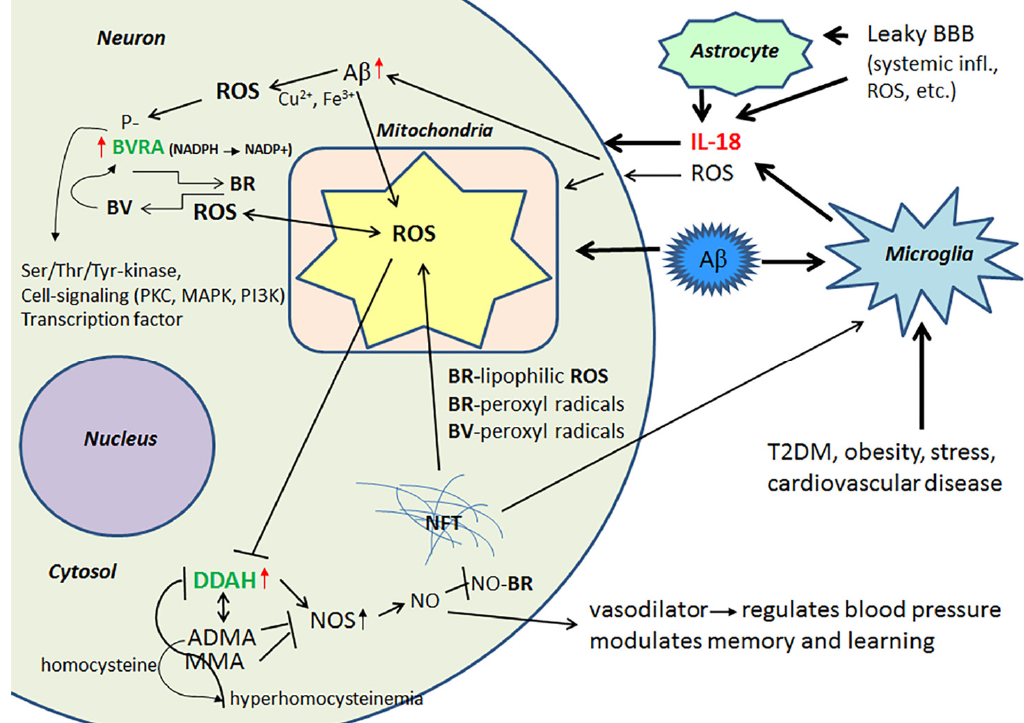
Figure 3. BVR/Biliverdin/bilirubin system and DDAH. IL ‐ 18 is a regulator of BVRA, which maintains the functional antioxidative BV/BR ‐ system. BVRA is activated by phosphorylation [66]. BVRA also influences cell signaling and transcription. Dysregulation of DDAH can lead to hyperhomocysteinemia, a risk factor for instance for AD and atherosclerosis. Red arrow, influenced by IL ‐ 18 [40,42].